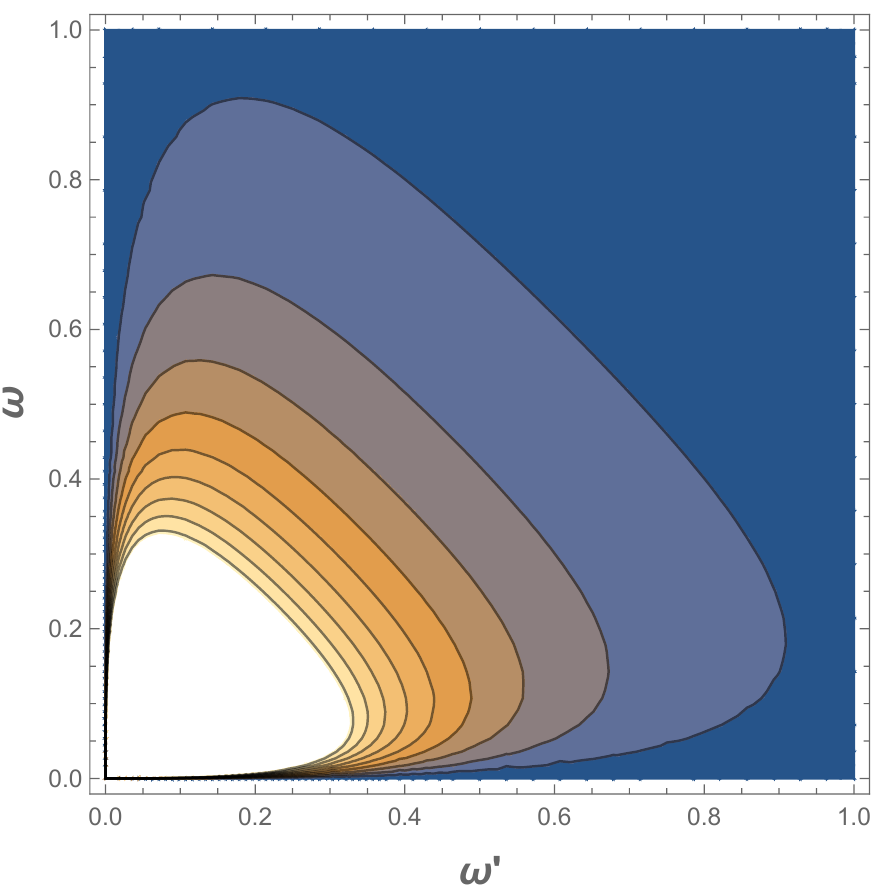
Figure 3. A contour plot of the coefficients (13) as a function of in and out modes, ω (cid:48) and ω , where final constant speed, s = 0.444 and κ = 1. The color gradient darkens for lower values of the count. This plot underscores the symmetry of the modes in the particle per mode squared distribution spectrum of the Bogoliubov β coefficients